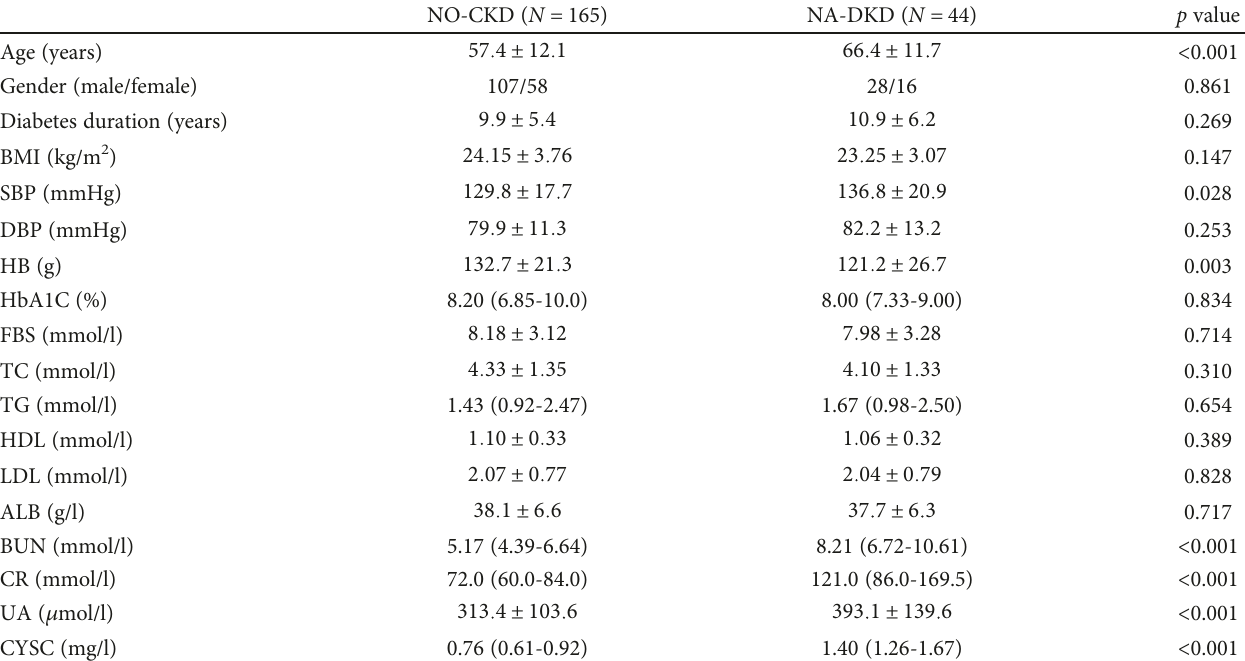
Table 1: Clinical characteristics of T2DM patients with